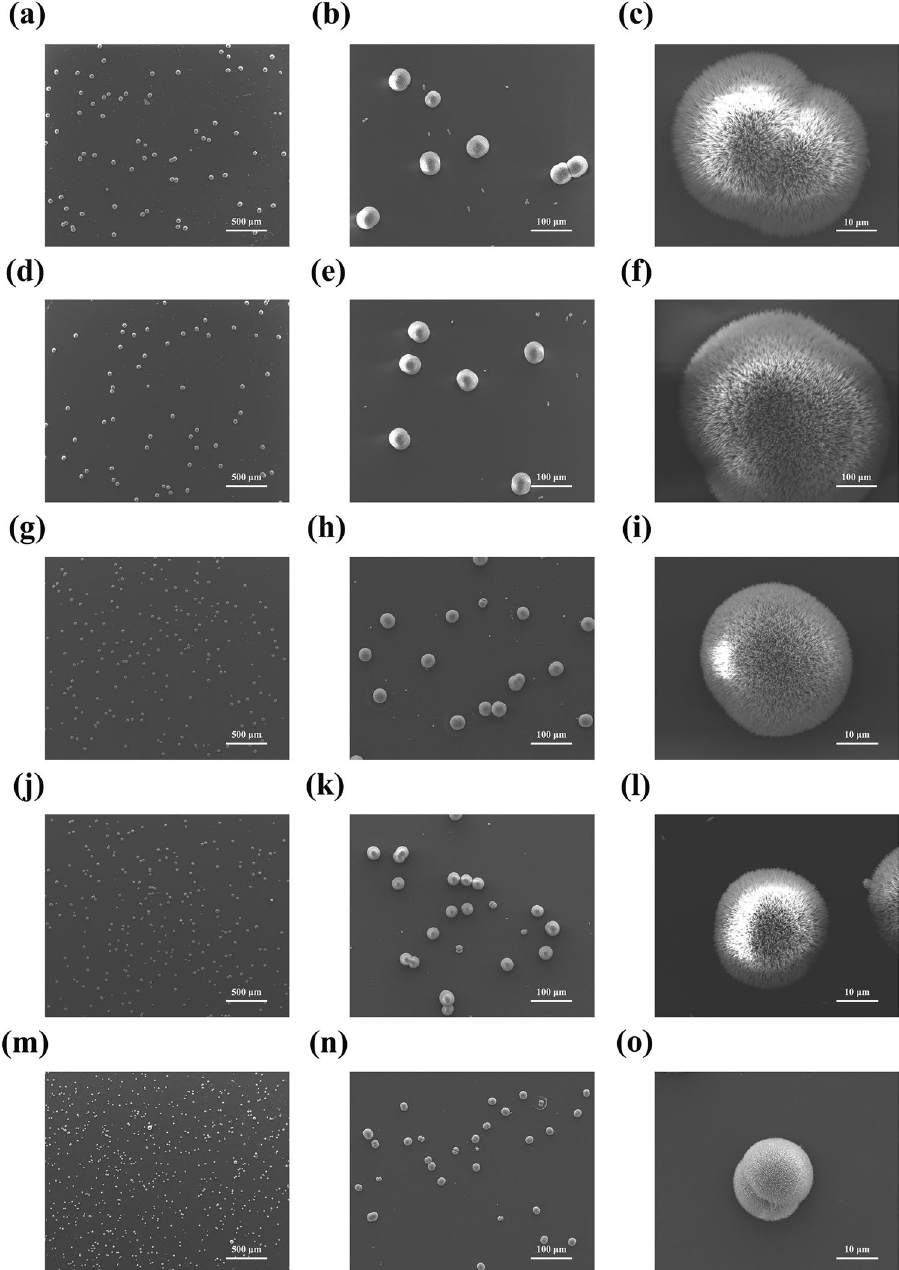
Figure 7. SEM images of in vitro aragonite crystallization in the presence of rPfY2. Crystals grown in the presence of 80 μ g/ml BSA ( a – c ); 80 μ g/ml MBP ( d – f ); 30 μ g/ml rPfY2 ( g – i ); 50 μ g/ml rPfY2 ( j – l ); 80 μ g/ml rPfY2 ( m – o ). The middle and right columns were high-magnification images of the associated